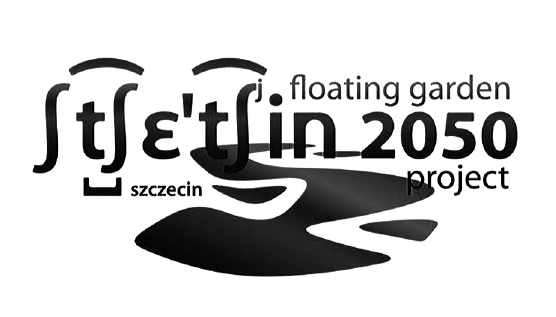
Fig. 3. logo of the Szczecin Floating Garden 2050 Project (in the original coloured version in green and blue). Source: